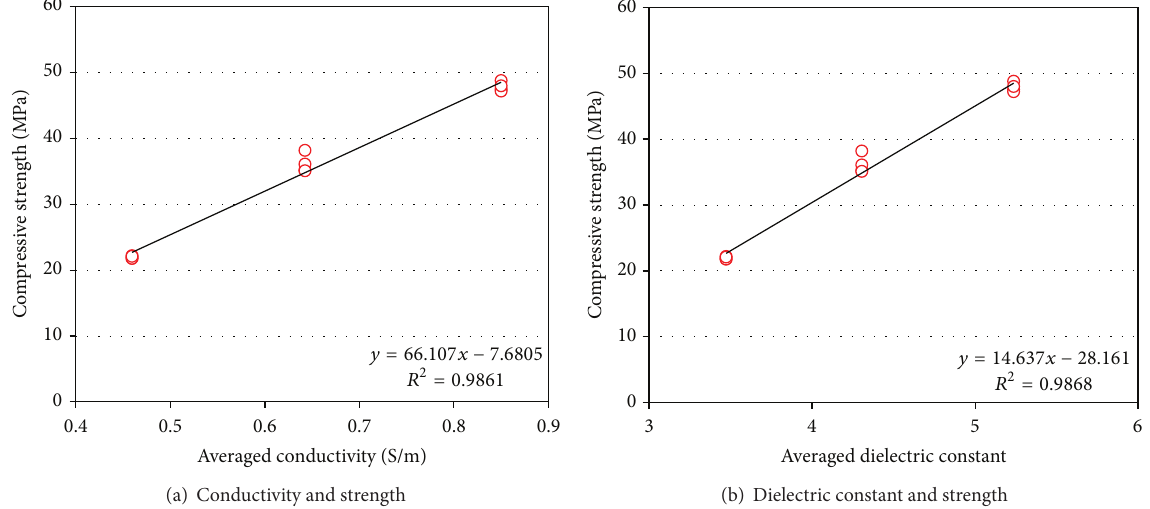
Figure 9: EM properties and compressive